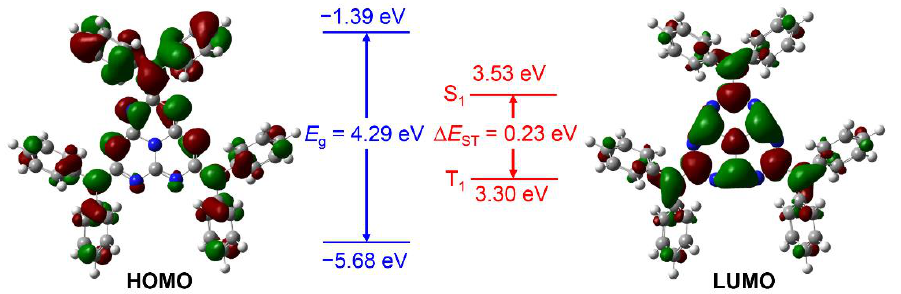
Figure 1. Frontier molecular orbital distributions and energy levels of the lowest excited singlet and triplet states of HAP-3DPA by theoretical